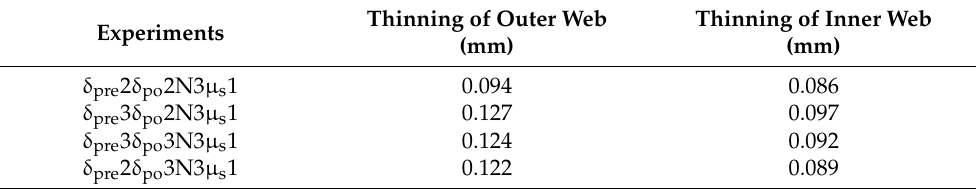
Table 6. Numerical simulation results of four combinations.